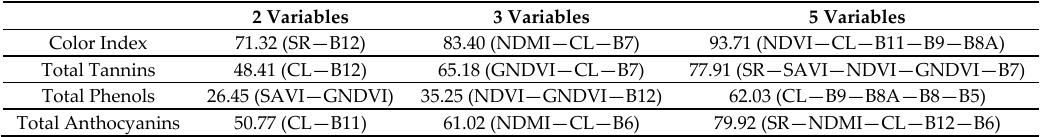
Table 2. Determination coefficients, using a multiple regression model. Average pixel comparison within a 15 m buffer around the sample.